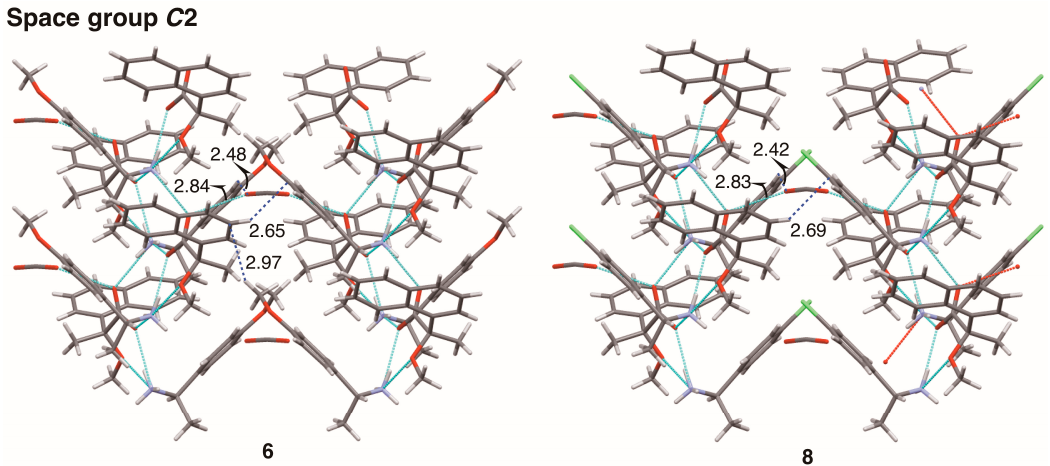
Figure 14. Molecular packing of salts 6 and 8 viewed along the c -axis. Numbers without units represent interatomic distances (Å). The pale-blue dotted lines indicate hydrogen bonds and salt bridges. Van der Waals radii: aromatic H, 1.00 Å; H, 1.20 Å; O, 1.52 Å; half-thickness of the benzene ring, 1.77